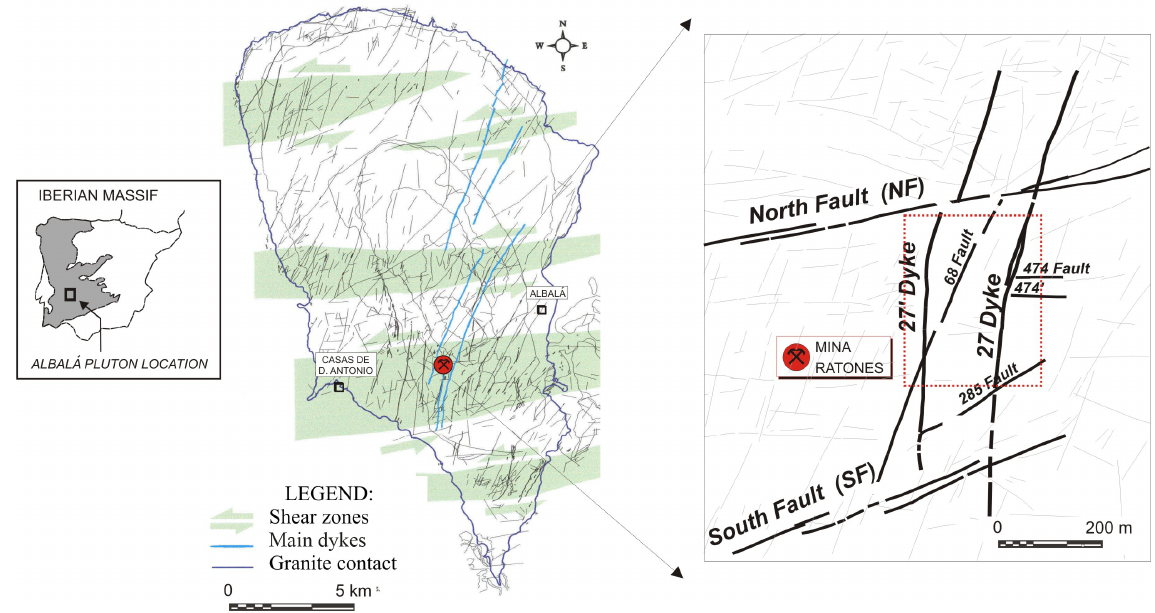
Figure 1. Geological map of Albalá granitic pluton with location of the Mina Ratones area (ENRESA, 1996; Escuder-Viruete and Perez- Estaun,